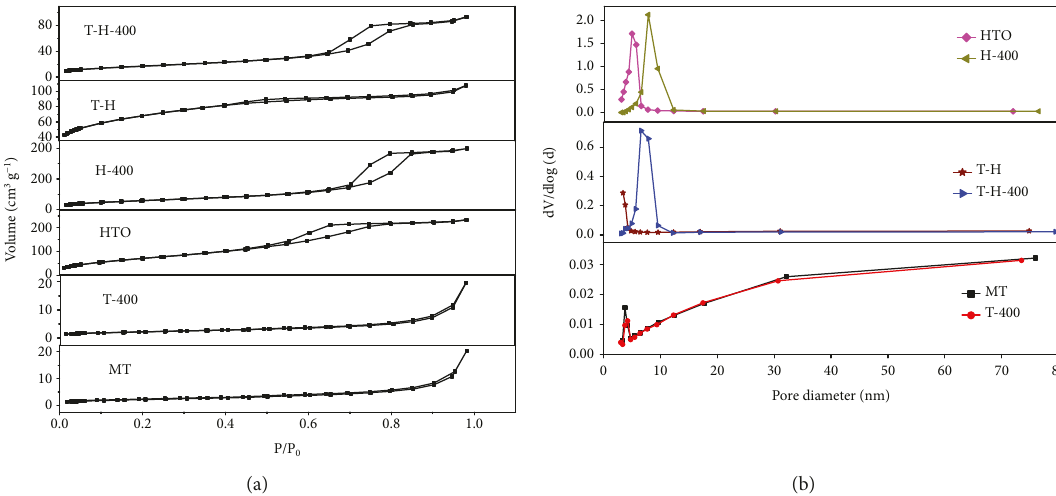
Figure 7: (a) Nitrogen adsorption-desorption isotherms for all samples; (b) pore diameter distribution curves of all